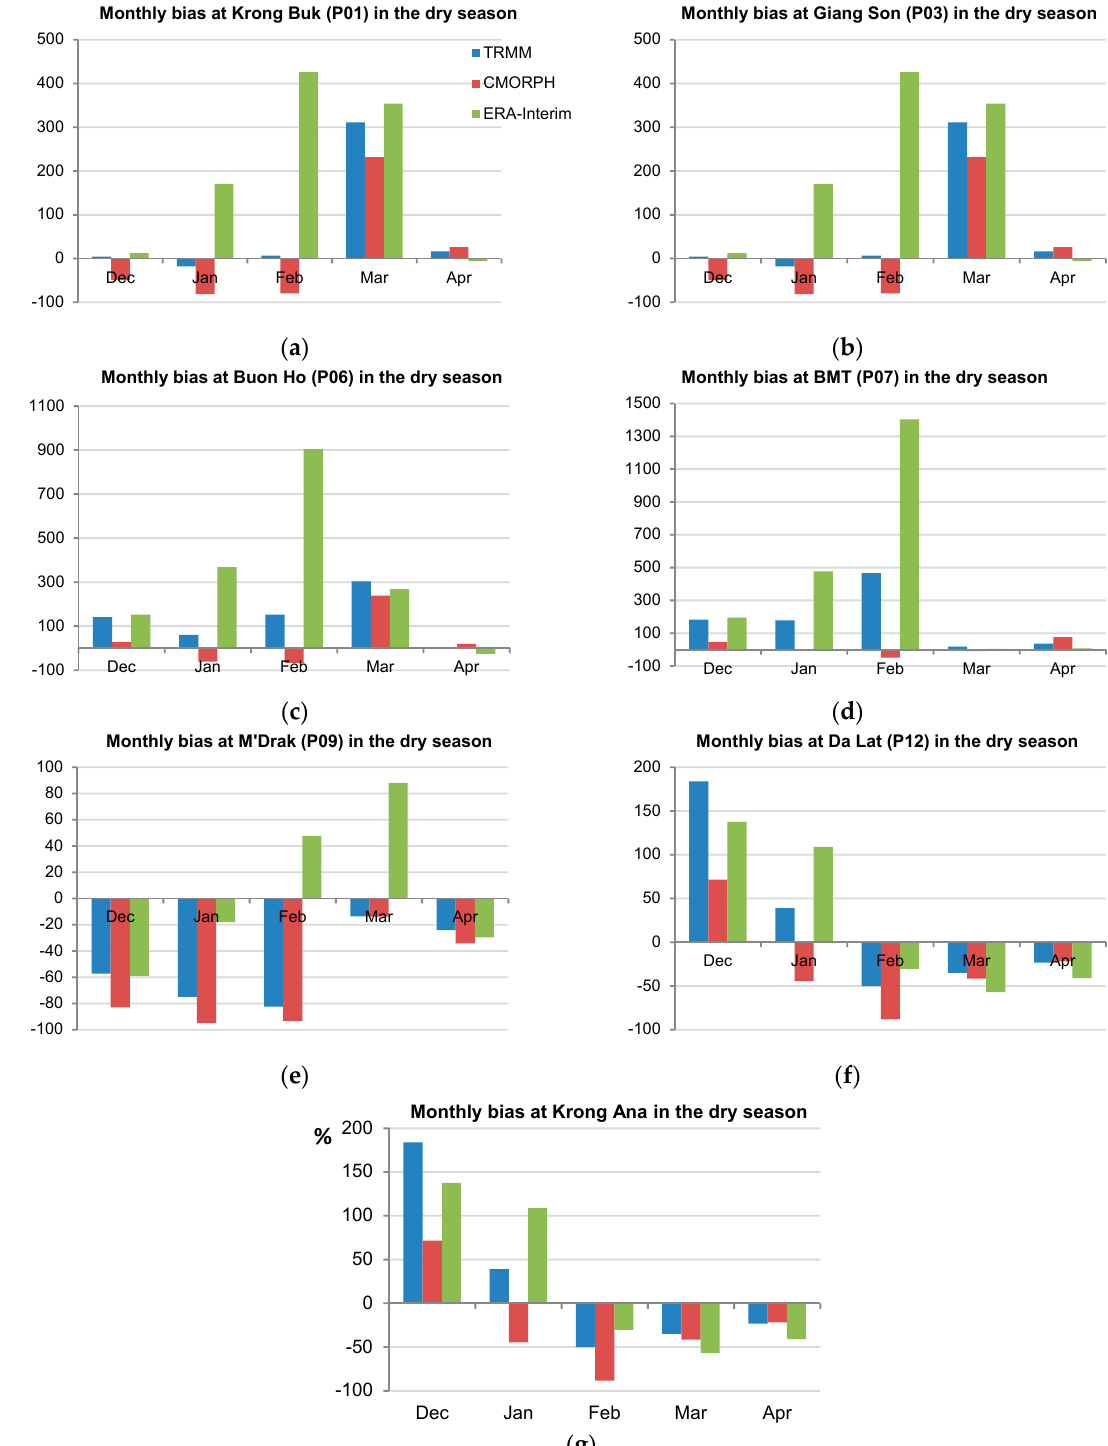
Figure 5. Monthly bias (%) of different SBRP data sets compared to GMP data in dry season at different stations and Krong Ana Sub-catchment: ( a ) at Krong Buk station (P01), ( b ) at Giang Son station (P03), ( c ) at Buon Ho station (P06), ( d ) at BMT station (P07), ( e ) at M'Drak station (P09), ( f ) at Dat Lat station (P12), and ( g ) at Krong Ana Sub-catchment.